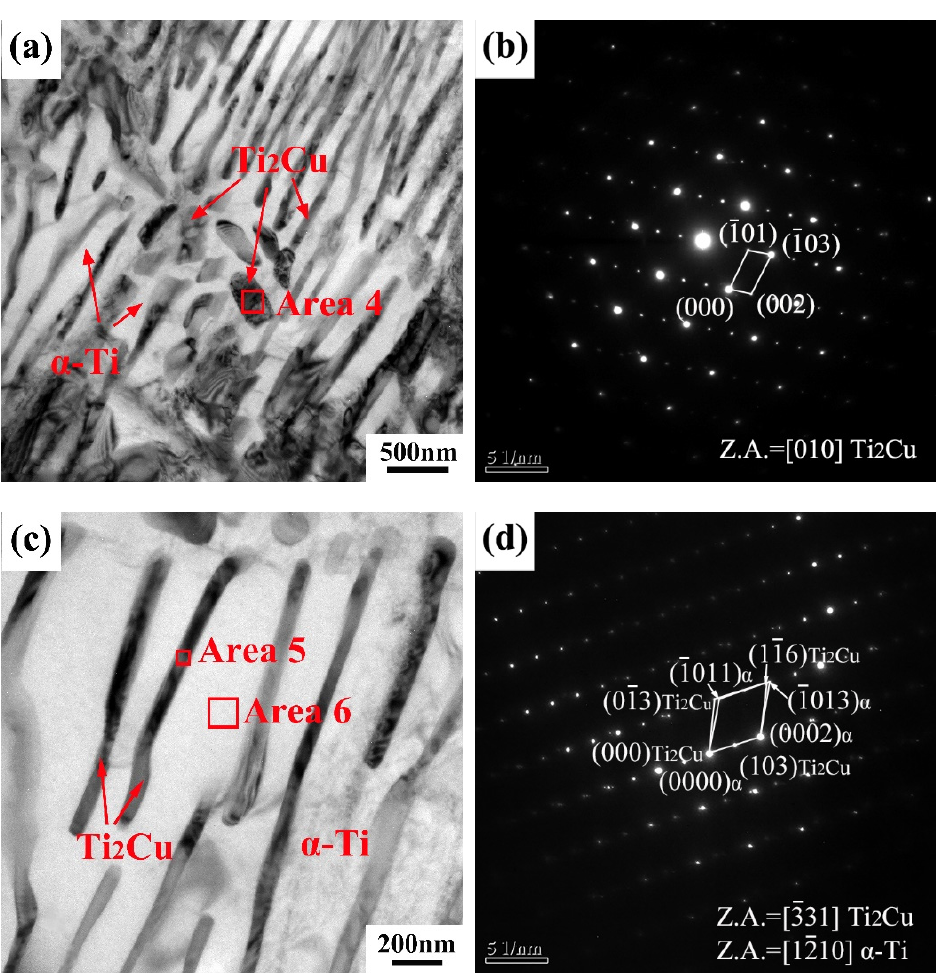
Figure 7. ( a , c ) bright field TEM images of as-cast Ti-10Cu alloy; ( b ) SAED pattern taken from the area 4 in ( a ); ( d ) the complex SAED pattern of the lath Ti 2 Cu (Area 5) and α phase taken from in ( c ). Table 3. EDS analysis results of the Ti 2 Cu and α -Ti phases in Ti-xCu alloys marked in Figures 6 and 7 (at.%).